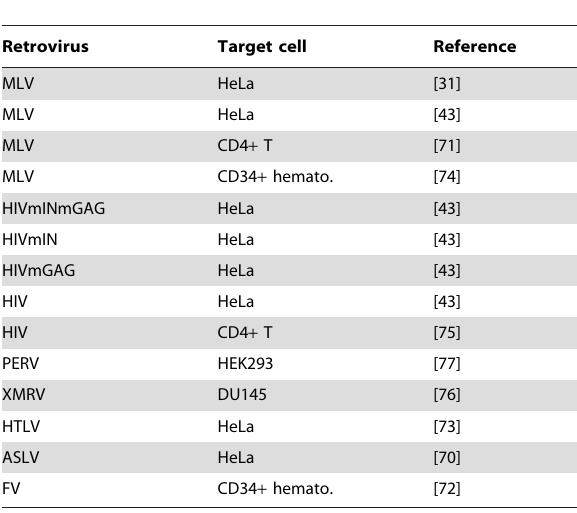
Table 2. Retrovirus integration datasets in human target cells used in this